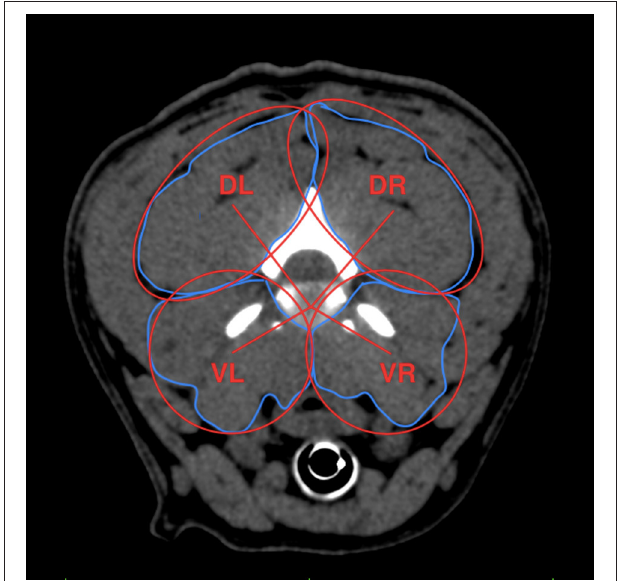
FIGURE 5 | Measurement scheme describing the distances between the disk center and assumptive center of the muscle groups calculated with ellipsoid models to further determine respective relation of moments. Red lines describing lever arms of each paraspinal muscle group. DR, dorsal right; DL, dorsal left; VR, ventral right; VL, ventral left.